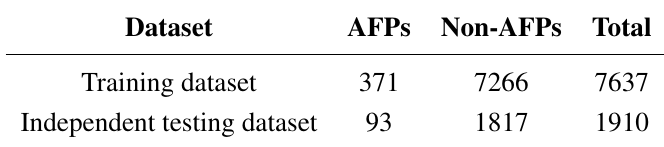
Table 6. The number of samples in the training dataset and independent testing